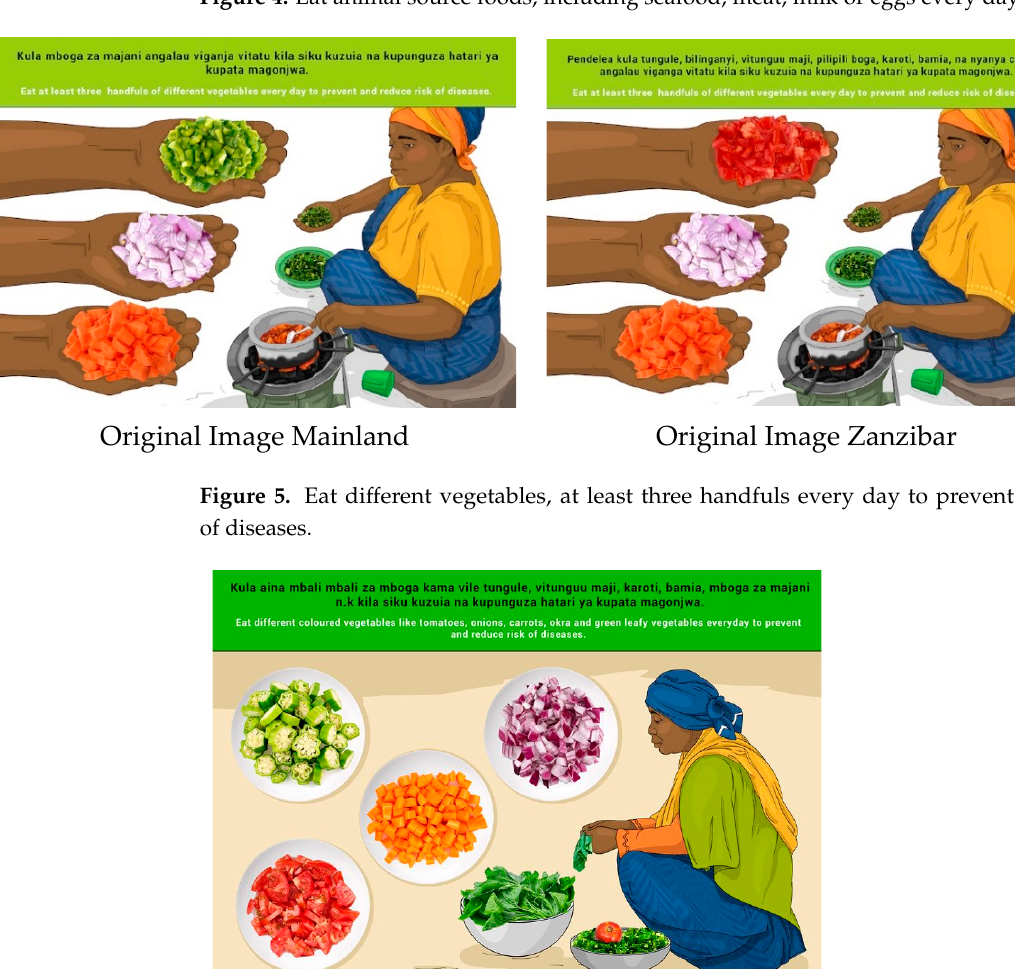
Figure 5. Eat different vegetables, at least three handfuls every day to prevent and reduce risk of diseases.